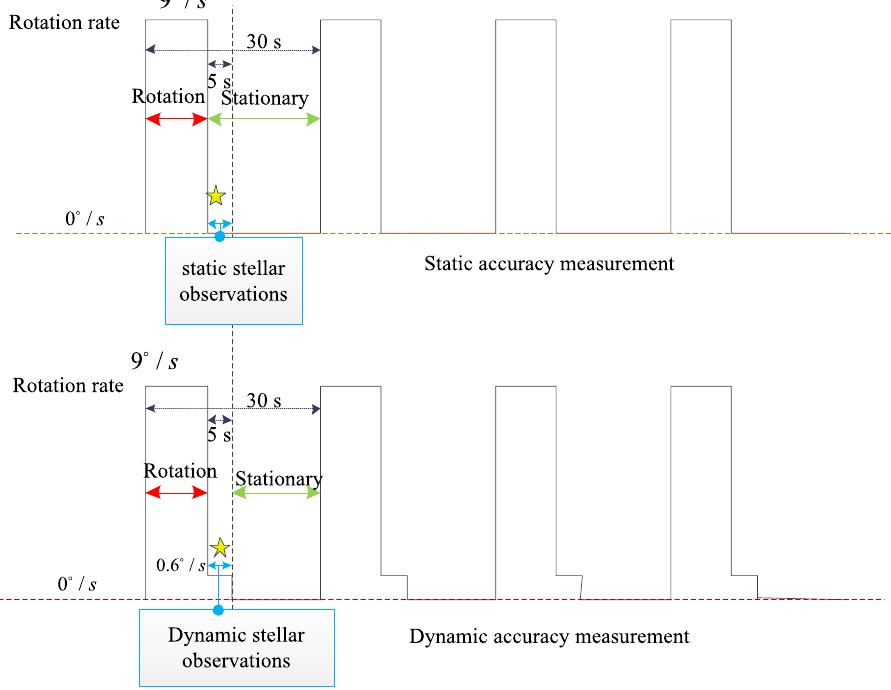
Figure 4. Comparison between static and dynamic experiments.